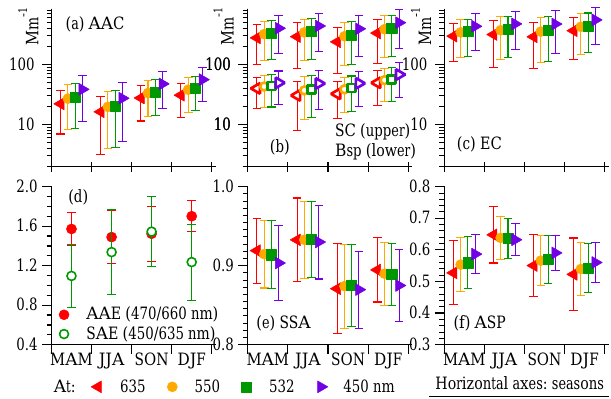
Horizontal axes: seasons Figure 2. Seasonal means (markers) and corresponding standard deviations (error bars) of wavelength-dependent AAC ( a , Mm − 1 ), SC ( b , solid mark, Mm − 1 ), Bsp ( b , open mark, Mm − 1 ), EC ( c , Mm − 1 ), SSA (e) and ASP (f) at 450, 532, 550, 635nm, as well as AAE at 470 / 660nm ( d , red solid mark) and SAE at 450 / 635nm ( d , green open